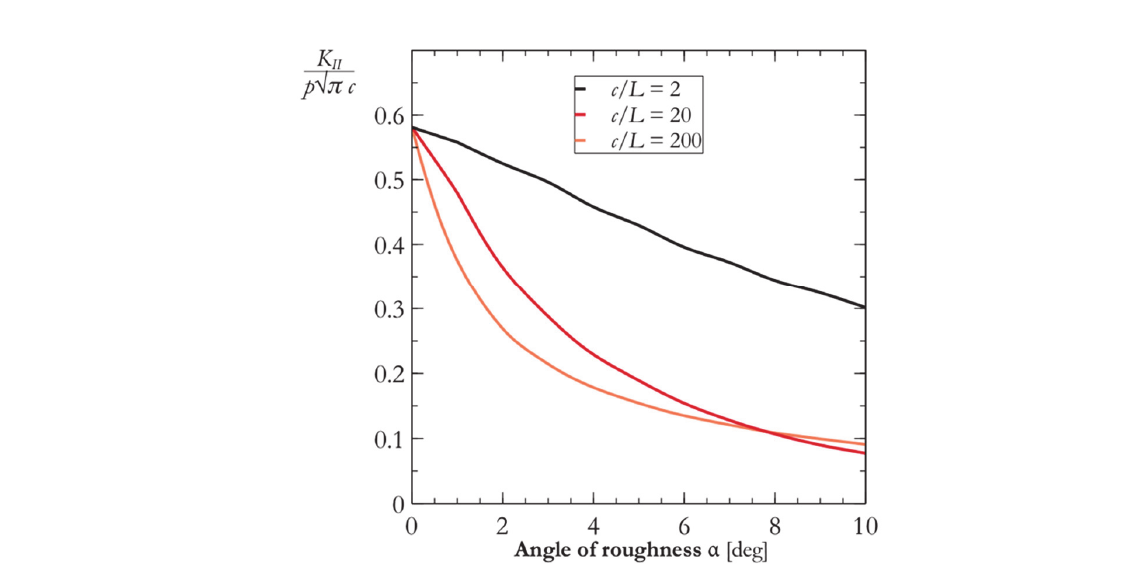
Figure 3: Variation of the normalised SIF K II with respect to the roughness angle, for q/p =1.